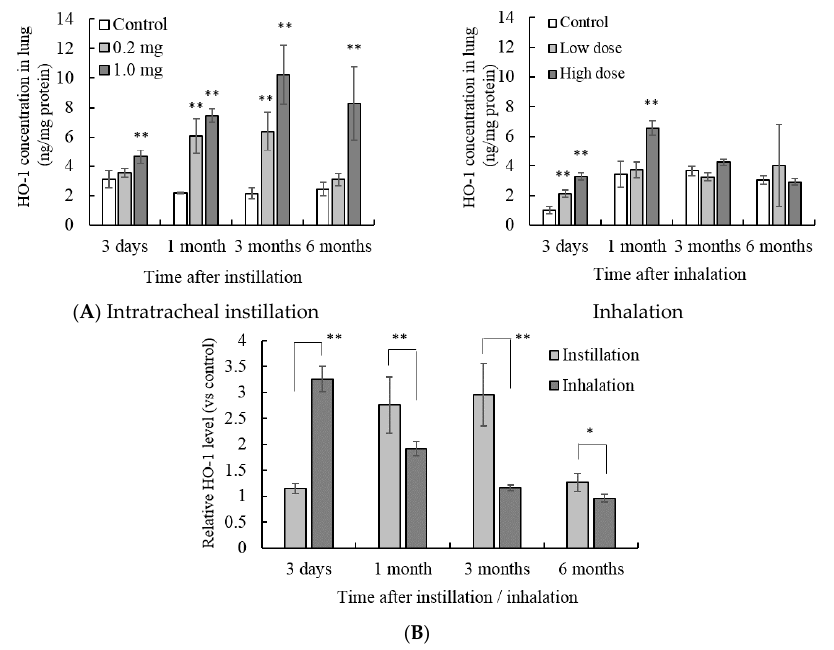
Figure 1. Influence of NiO nanoparticle exposure on the concentration of heme oxygenase-1 (HO-1) in lung tissue. ( A ) The concentration of HO-1 in the lung after intratracheal instillation and inhalation. The HO-1 concentration was measured by enzyme-linked immunosorbent assay (ELISA). Values are mean ± SE ( n = 5). Significant differences versus control group are indicated in the figure (ANOVA, Dunnet). ** p < 0.01; ( B ) Comparison of 0.2 mg intratracheal instillation and high dose inhalation. The data show the relative level of the HO-1 protein concentration against each control group. ** p < 0.01, * p < 0.05 (ANOVA, Tukey).